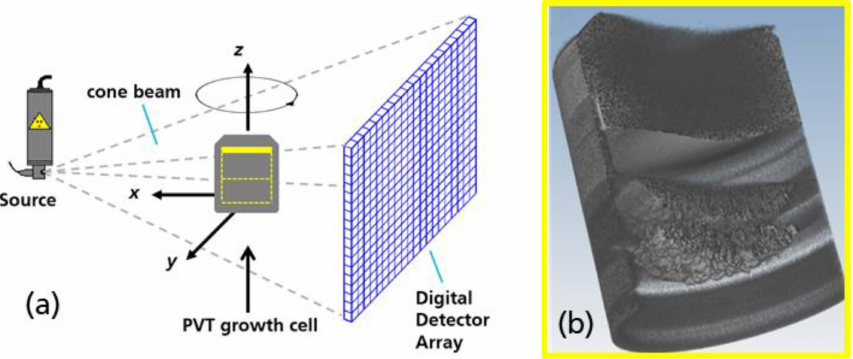
Figure 1. PVT-CT setup, ( a ) Computed tomography (CT) principle applied to the crystal growth. ( b ) Resulting CT volume measured in situ, reconstructed and 3D rendered with an opened cross-section plane.